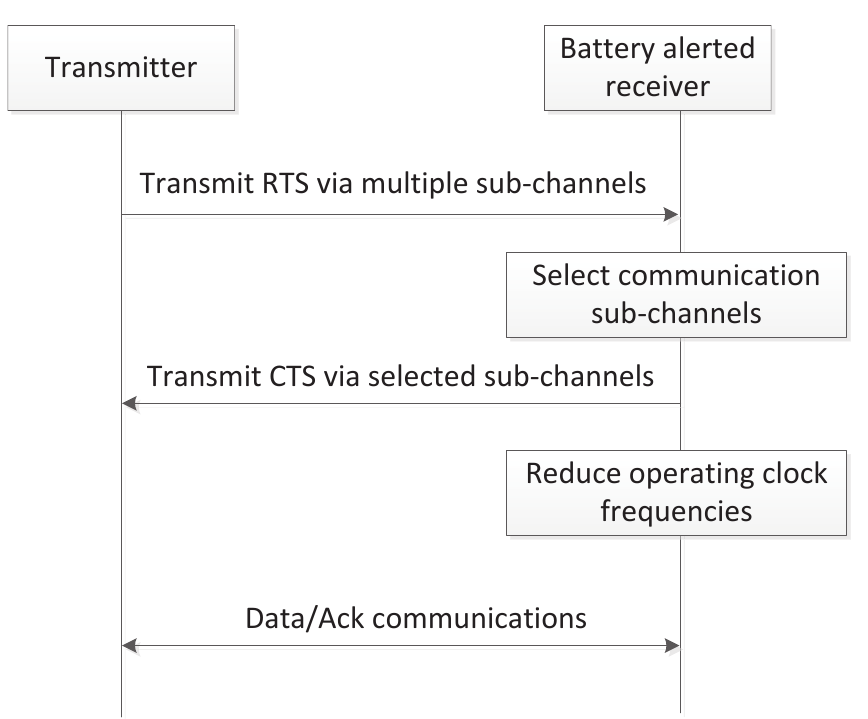
Figure 3. Flowchart for dynamic energy saving